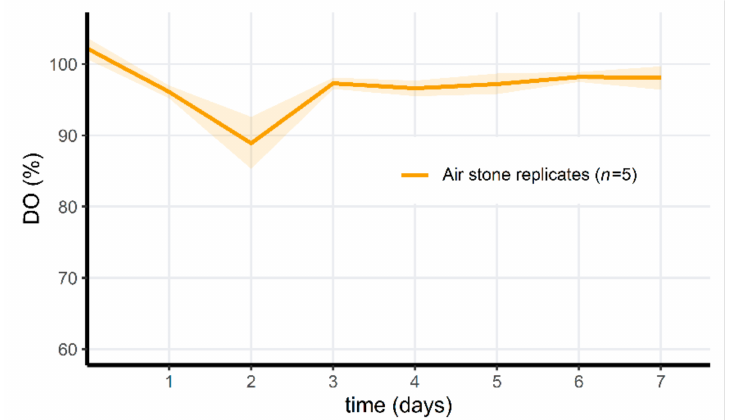
Figure 7. Mean dissolved oxygen (%) through time during the third microcosm exposure experiment. All microcosms were aerated and treated with PAA. Shaded areas indicate mean ± standard deviation. Notice the scale difference on the y-axis compared to Figure